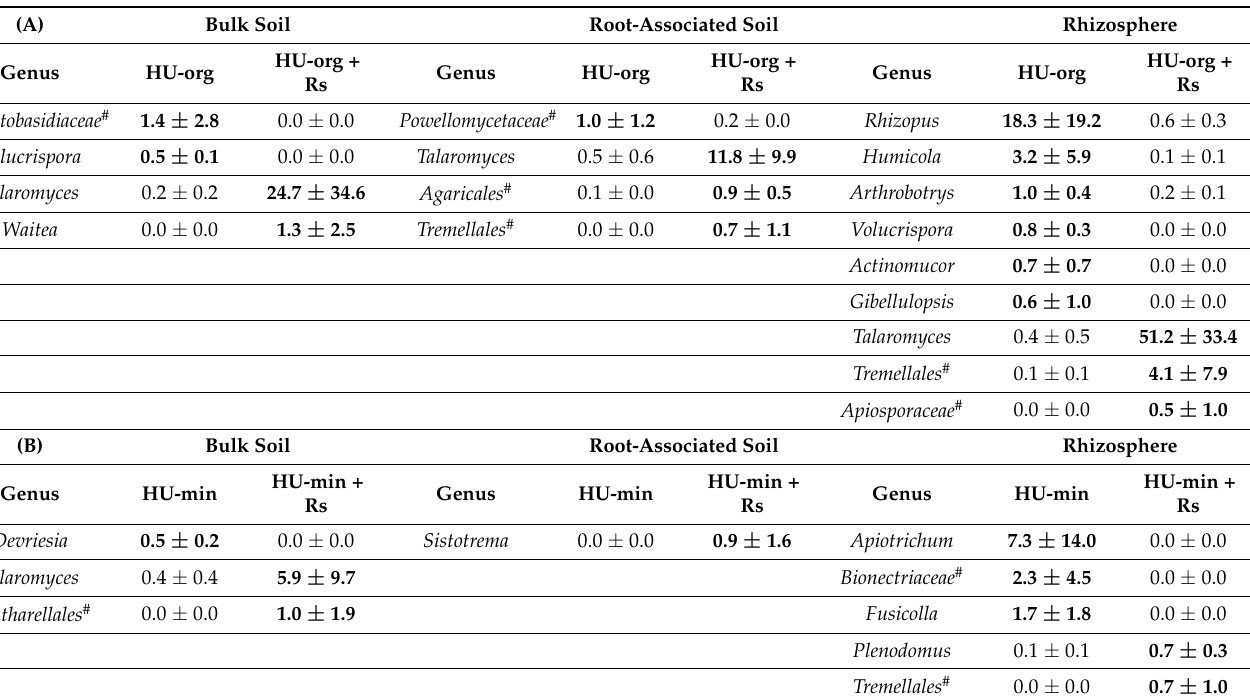
Table 6. Fungal genera in bulk soil, root-associated soil and rhizosphere of lettuce (cv. Tizian) differing significantly (FDR < 0.05) in relative abundance depending on the absence and the presence of Rhizoctonia solani AG1-IB (Rs) in long-term ( A ) organic- and ( B ) mineral-fertilized soils. Mean ± standard deviation of taxa with >0.5% relative abundance is displayed. Bold numbers indicate significant